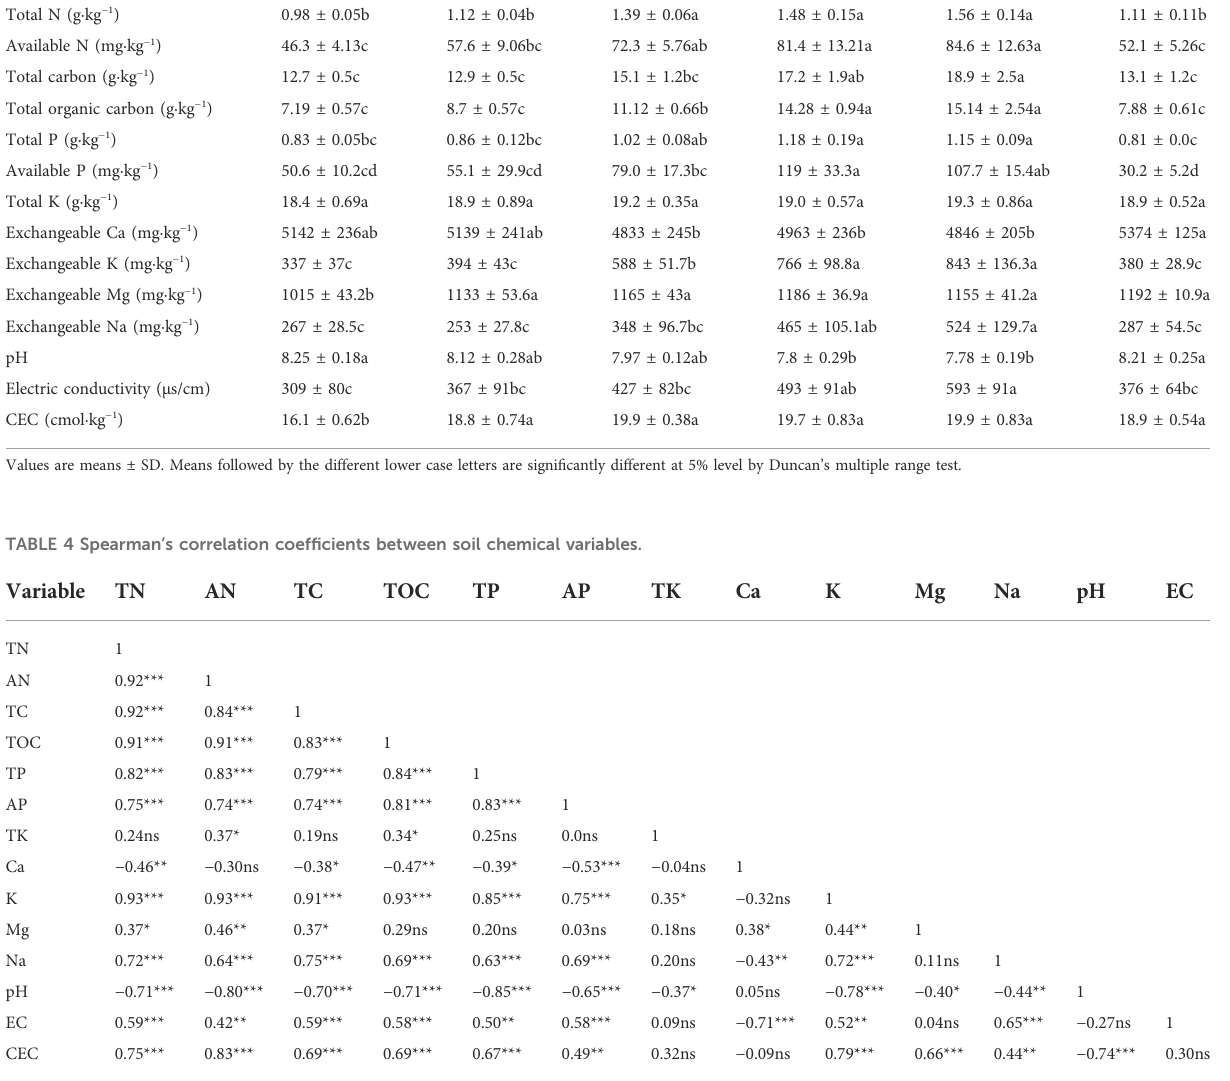
the RF plots, respectively ( p < 0.05). In the TF plots, the activity of nitrite reductase increased 98.7% and 27.6% more than in all organic fertilizer treatments and RF plots ( p < 0.05). Compared with organic fertilizer treatments and RF plots, the polyphenol oxidase activity of TF plots increased by 65.5% and 35.3%, respectively. However, the activity of polyphenol oxidase was not signi fi cantly different between TF and UC plots ( p < 0.05).